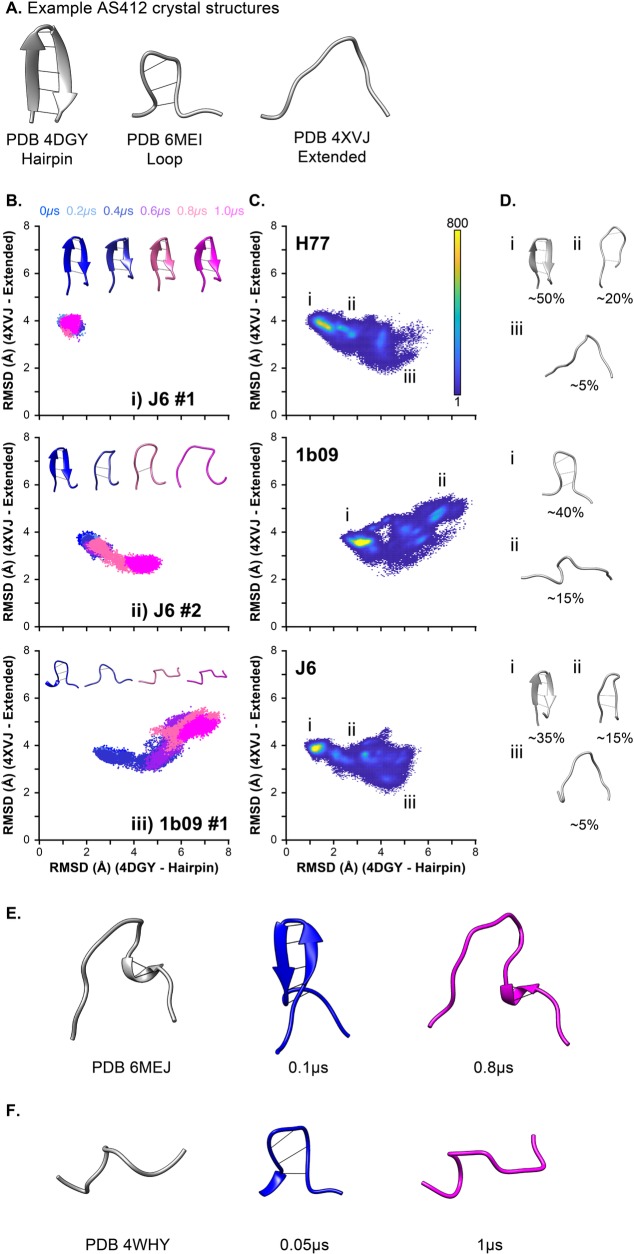
Molecular dynamic simulations capture conformation transitions in AS412.Crystal structures of E2 ectodomain, or E2 derived peptides, in complex with various antibodies have revealed conformational plasticity of AS412. A. Representative structures of AS412 in a β-hairpin (PDB 4DGY), closed loop (PDB 6MEI) or extended (PDB 4XVJ) conformation. To assess conformational transitions of AS412 we measured backbone RMSD between each MD trajectory and reference structures in the β-hairpin (PDB 4DGY) or extended (PDB 4XVJ) conformations. B. Scatter plots of RMSD values for example simulations (as stated on the plot). The data points represent individual frames and are color-coded by time, as stated in the legend. Each plot includes representative AS412 structures from each simulation, also color-coded by time. C. RMSD scatter plot heat maps displaying the occupancy of AS412 in different conformational states across all simulations for each E2 model. The plots are color-coded for number of frames, as stated in the legend. D. Representative structures from different regions of the scatter plot (as annotated on C.), approximate values for the proportion of frames found within each state are provided. E. MD simulations recapitulate the extended AS412 conformation found in PDB 6MEJ, MD images are taken from a J6 E2 simulation. F. The extended conformation sampled in 1b09 simulations is similar to that observed in PDB 4WHY.